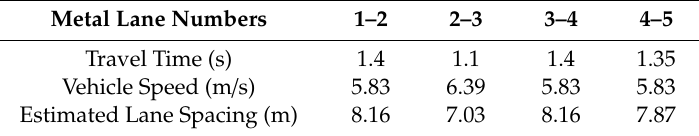
Table 2. Metal lane spacing estimation for Scenario 3.